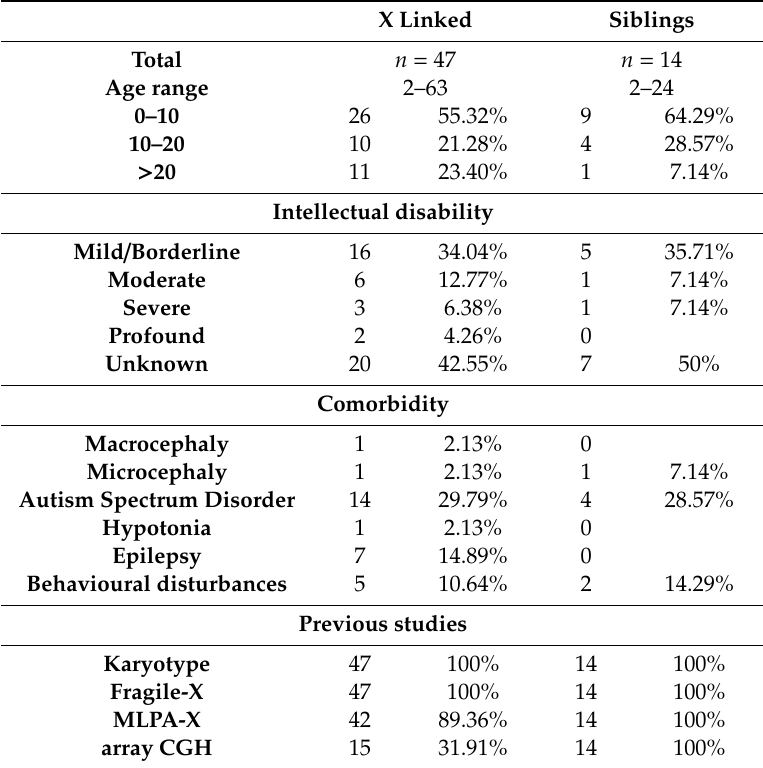
Table 1. Description of the selected cohort of 61 patients with suggestive X-linked intellectual disability. The cohort has been divided into two groups: Index males that have suggestive X-linked inheritance (X-linked) and index males with a ff ected brothers